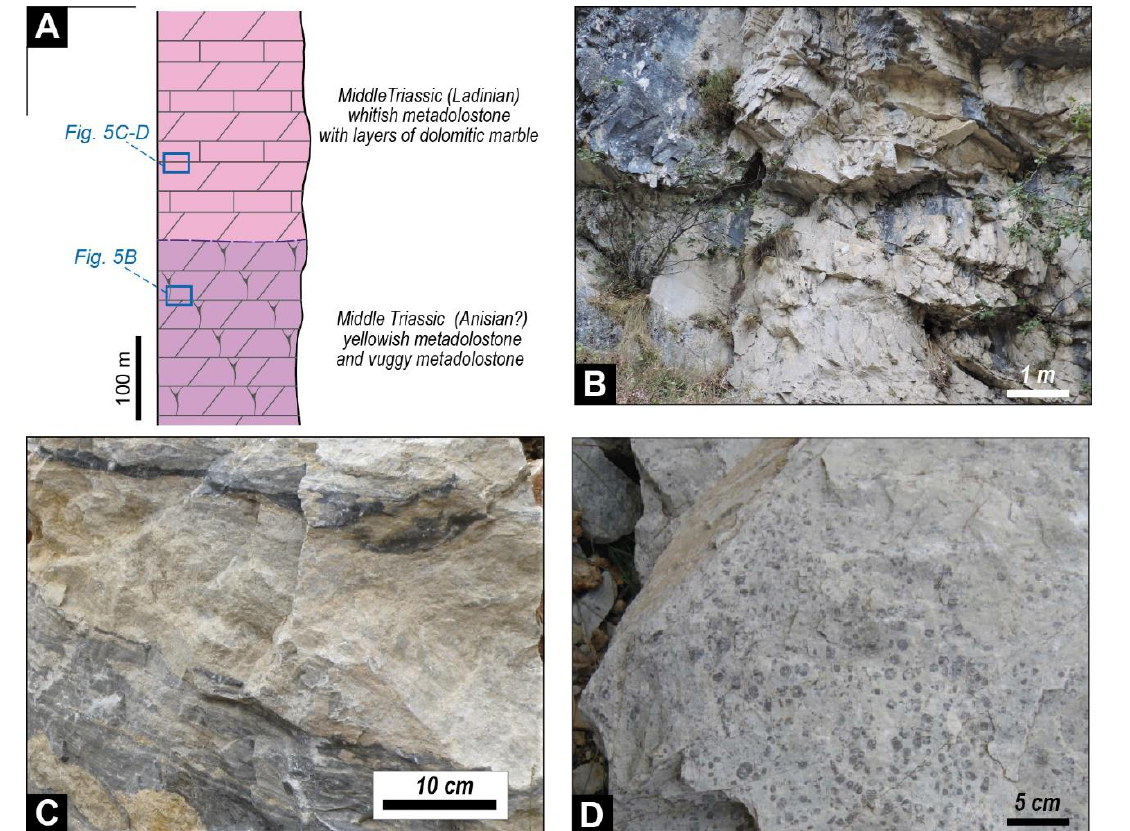
Figure 5. ( A ) Pre-Alpine stratigraphic columnar section of the Maira Unit (the stratigraphic location of the representative field images is shown); ( B ) (Anisian?) yellowish metadolostone (North-East of San Damiano); ( C ) close-up view of the Ladinian whitish metadolostone alternating with layers of grey dolomitic marbles (South of Dronero); ( D ) close-up view of the Ladinian whitish metadolostone retaining fragments of crinoids (South of Dronero).